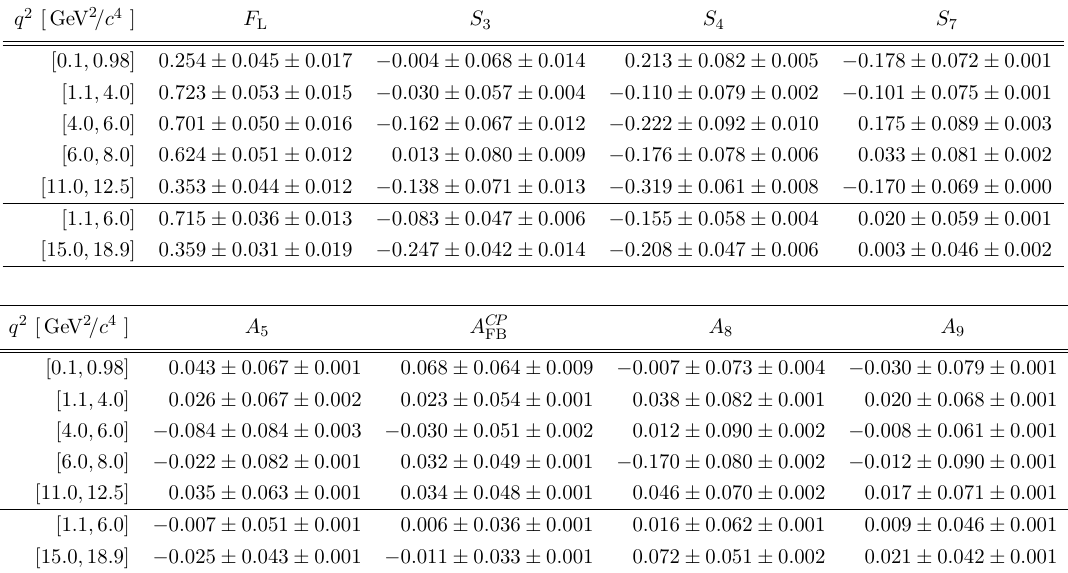
Table 1 . CP averages F L and S 3 , 4 , 7 and CP asymmetries A CP maximum likelihood fit. The first uncertainty is statistical and the second is the total systematic uncertainty, as described in section